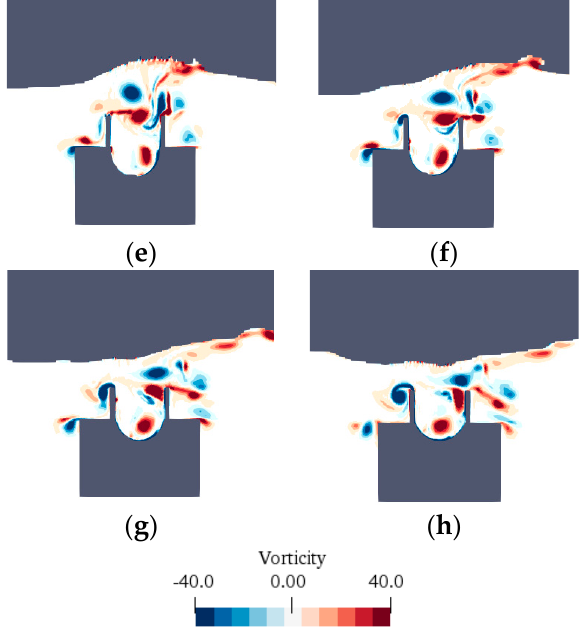
Figure 21. The instantaneous vorticity contour for T = 0.8 s in one wave period (H = 0.1 m and d = 0.18 m): ( a ) t = 1/8T, ( b ) t = 2/8T, ( c ) t = 3/8T, ( d ) t = 4/8T, ( e ) t = 5/8T, ( f ) t = 6/8T, ( g ) t = 7/8T, and ( h ) t = 8/8T.